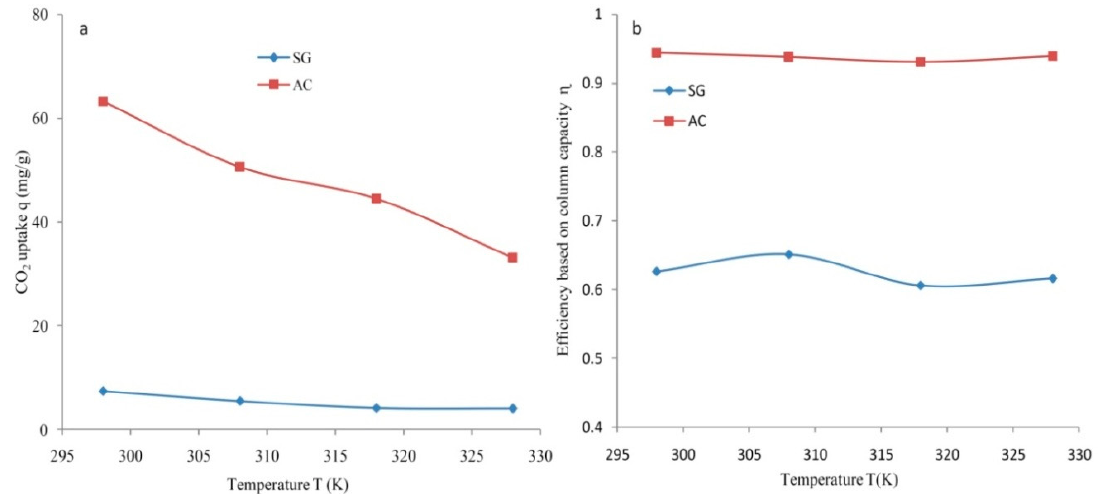
Figure 11. The dependence of temperature for SG and AC at C o = 5%, F = 4 lpm on ( a ) CO 2 uptake and ( b ) efficiency.